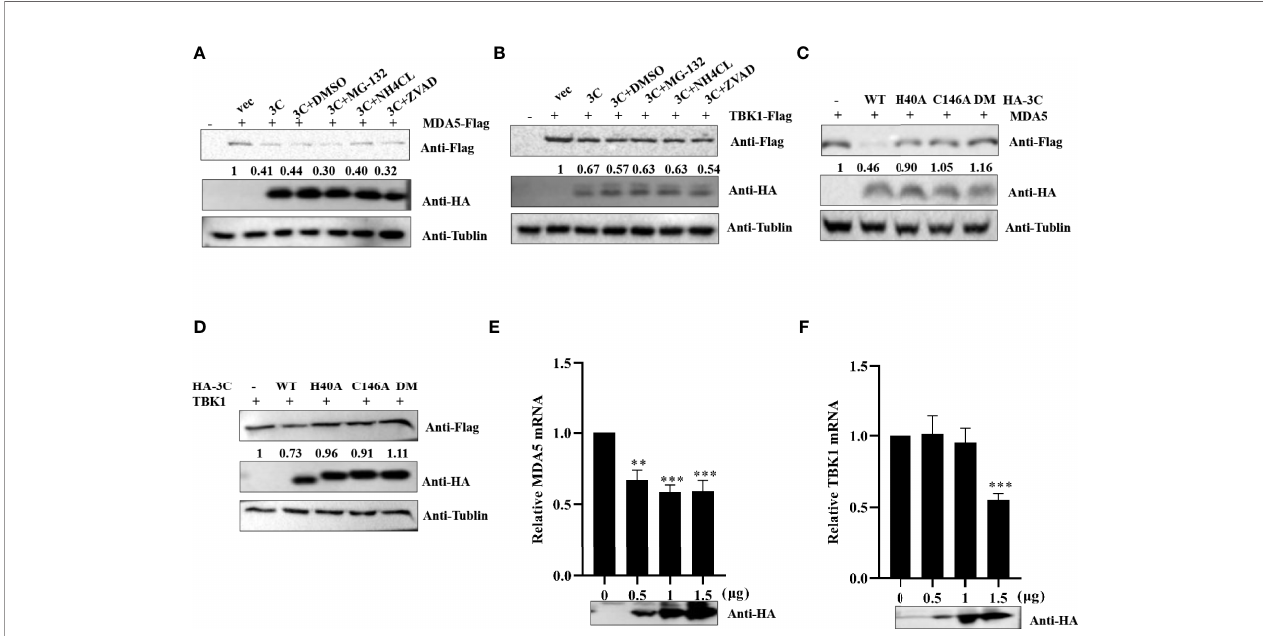
FIGURE 5 | PSV 3C pro inhibits the transcription level of MDA5 and TBK1. (A,B) HEK293T cells were seeded in 12-well plates, and the monolayer cells were co- transfected with 500 ng Flag-MDA5 or Flag-TBK1 and HA-3C for 12 h. Then the cells were treated with DMSO, MG132, NH4Cl, and Z-VAD-FMK for 12 h. The cells were collected for Western blotting. (C,D) The monolayer HEK293T cells in 12-well plates were co-transfected with 500 ng Flag-MDA5 or Flag-TBK1 and HA-3C or HA-3C-mutant. At 24 h post-transfection (hpt), the cells were collected and lysed for Western blotting. (E,F) The monolayer HEK293T cells in 12-well plates were co- transfected with different doses of HA-3C (0 ng, 200 ng, 800 ng) for 24 h, and then the cells were collected for RT-qPCR. 3C pro expression was detected by Western blotting using the HA antibody. Student ’ s t-test: **P < 0.01, ***P <